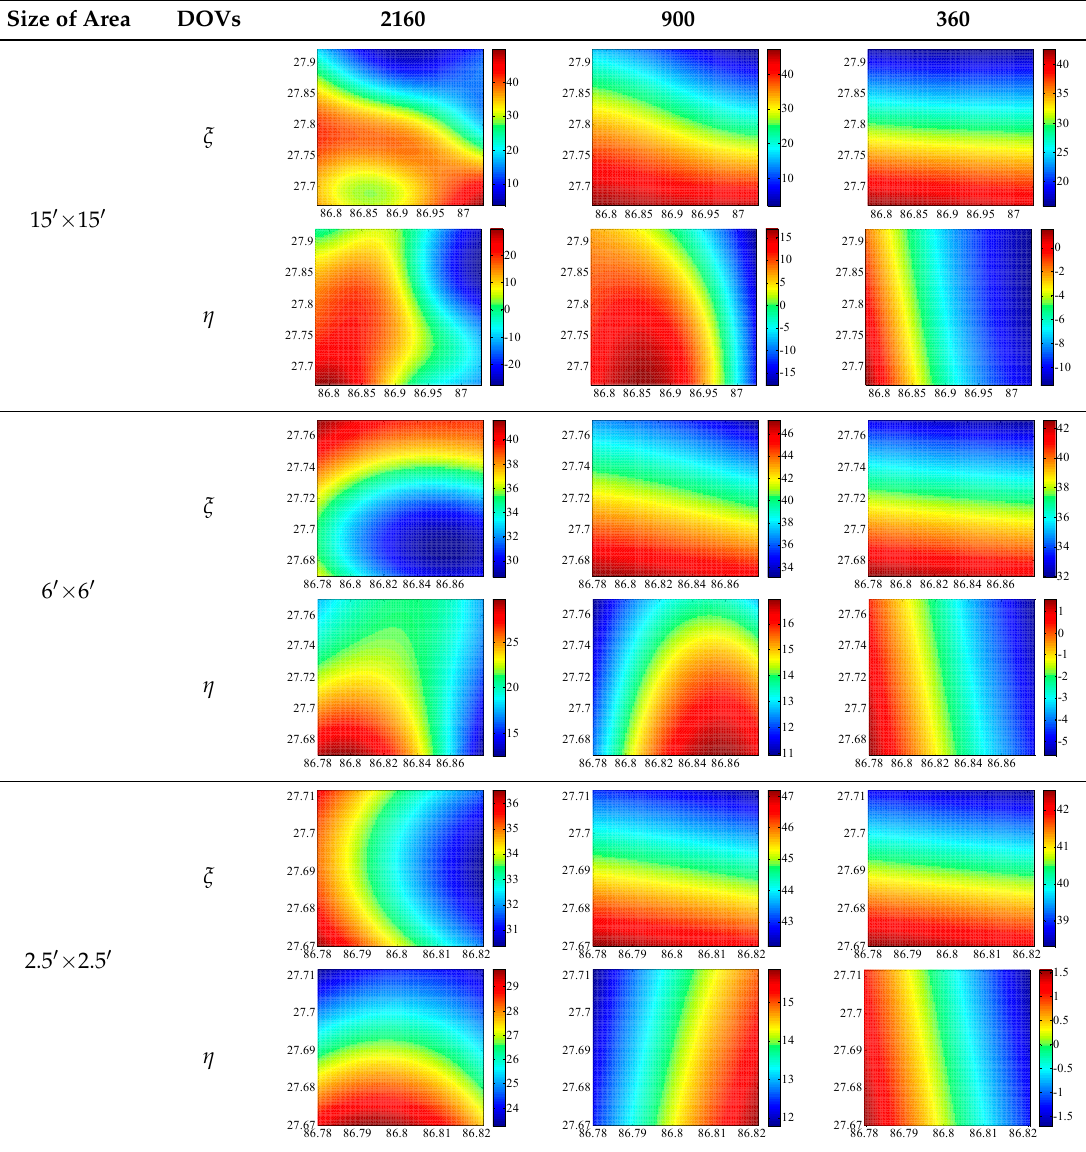
Table 2. DOVs of different area sizes in the